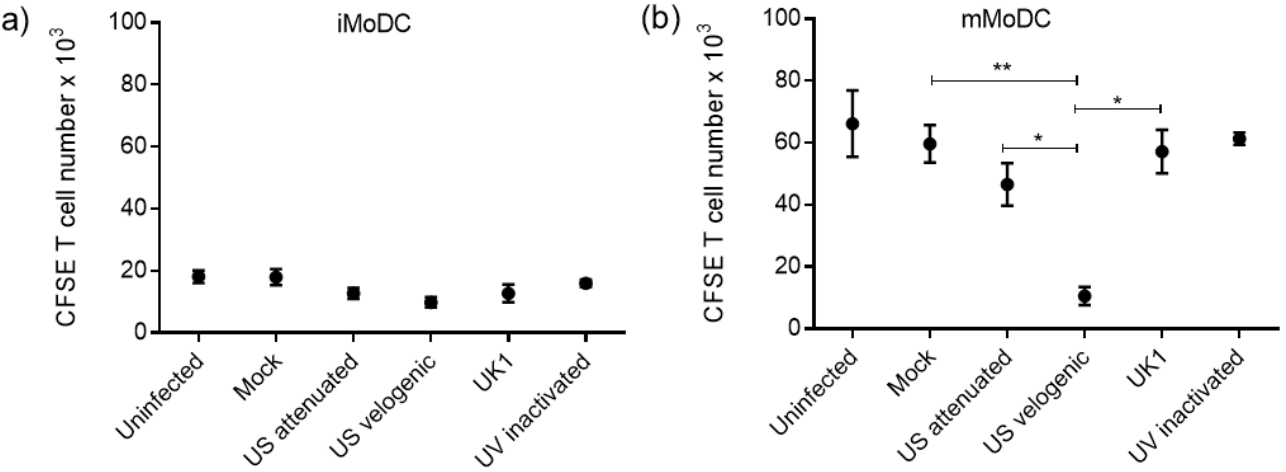
Figure 10. The ability of EAV infected equine MoDC to stimulate T cells in in vitro mixed leukocyte reactions (MLR). Immature MoDC (iMoDC) and mature MoDC (mMoDC) were inoculated at MOI of 5 with different strains of live or UV inactivated EAV. Cultures were incubated at 37 °C in 5% CO 2 for 2 h prior to the addition of CFSE (FITC) labelled allogeneic T cells and further incubated at 37 °C for 3 days. Cells of the different treatments were analyzed using flow cytometry by comparing the same number of events (10,000) in the target gate. ( a ) There were no significant differences in the allostimulatory capacity of iMoDC infected with different EAV strains, although there was a trend in reduction. ( b ) There was a significant difference in the allostimulatory capacity of mMoDC infected with the Velogenic strain. Results are represented as proliferating T cell numbers ± SEM ( n = 4). A 1-way ANOVA with Dunn’s post-test was used to compare replicate means. * and ** indicate significant differences between sample means where p < 0.05 and p < 0.001, respectively.